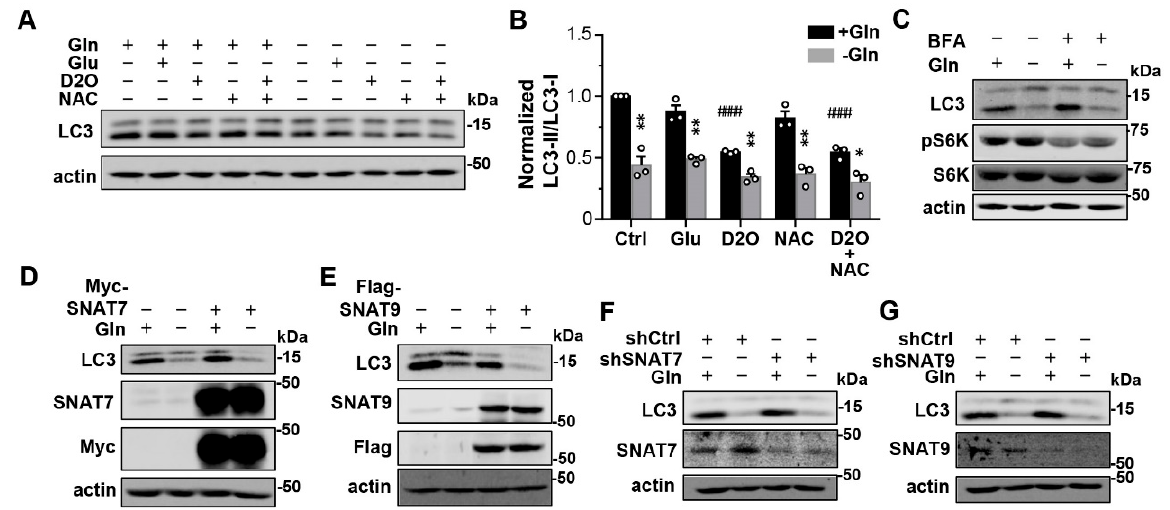
Figure 3. Glutamine regulates lysosomal degradation through a mechanism unrelated to oxidation, Gln-driven energy metabolism, or lysosomal amino acid sensing. ( A ) Representative Western blot analysis of LC3 and actin of MEF cells treated with Glu (4 mM), DM-2-OG (D2O, 6 mM), and/or NAC (6 mM), as indicated, in the presence or absence of Gln for 1 h. ( B ) Statistics of LC3-II/LC3-I ratios normalized to that of untreated Ctrl for conditions shown in ( A ) from n = 3 experiments. Note, none of the treatments affected the Gln withdrawal effect; D2O also decreased LC3-II in the control medium. * p < 0.05, ** p < 0.01 vs. corresponding +Gln by Grouped analyses—multiple t tests; #### p < 0.0001 vs. Ctrl +Gln, by one-way ANOVA with Dunnett’s multiple comparisons test. ( C ) Western blot analysis of LC3, pS6K (T389), total S6K, and actin of MEF cells untreated or treated with BFA (10 µM) in the presence and absence of Gln for 1 h. ( D , E ) Western blot analysis of LC3, SNAT7, Myc tag, and actin of MEF cells that overexpressed Myc-SNAT7 ( D ) and of LC3, SNAT9, FLAG tag, and actin of MEF cells that overexpressed Flag-SNAT9 ( E ). Ectopic expression was achieved via lentiviral transduction. Cells were kept in the normal culture medium or subject to Gln withdrawal for 1 h. ( F , G ) Western blot analysis of LC3 and actin of MEF cells that received control shRNA (shCtrl), or shRNA against SNAT7 (shSNAT7, ( F )) or SNAT9 (shSNAT9, ( G )) via lentiviral transduction. Cells were kept in the normal culture medium or subject to Gln withdrawal for 1 h. Knockdown efficiency was evaluated by Western blotting with anti-SNAT7 ( F ) and anti-SNAT9 ( G )